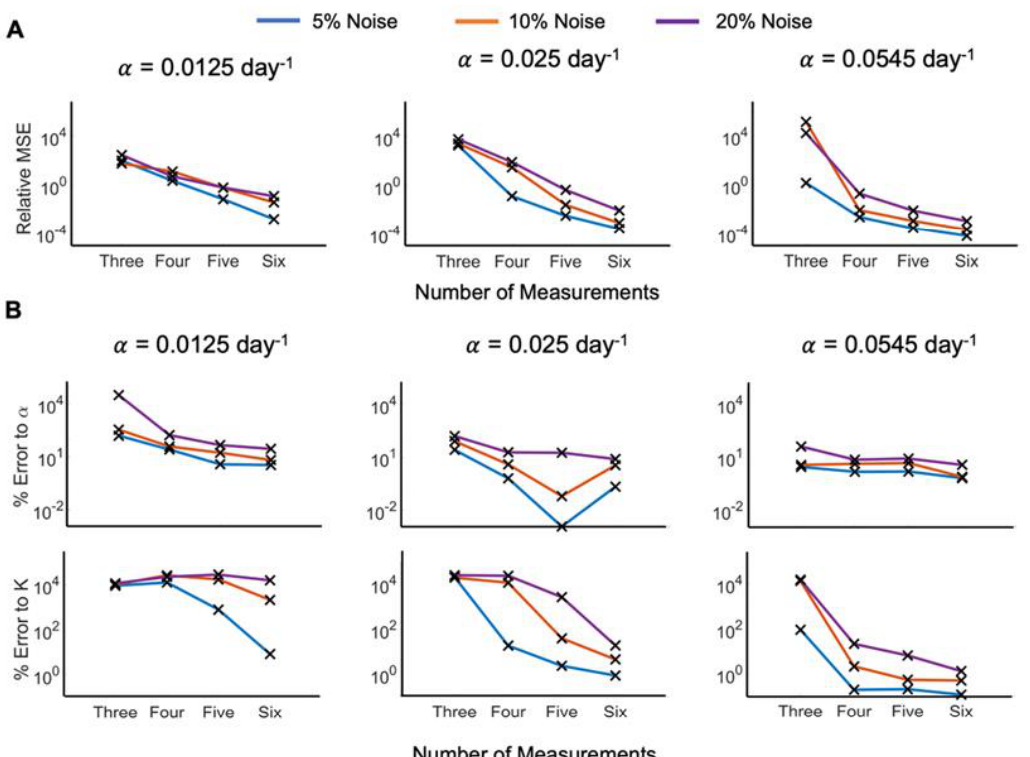
Figure 6. Comparison of error analyses for model fit and percent error across the different noise levels. ( A ) Relative mean squared error (MSE) between model prediction and ground truth data for different growth rates and noise levels in the data. ( B ) Comparison of percent error of model parameters (growth rate, α , and carrying capacity, K ) to ground truth for different growth rates and noise levels in the data.